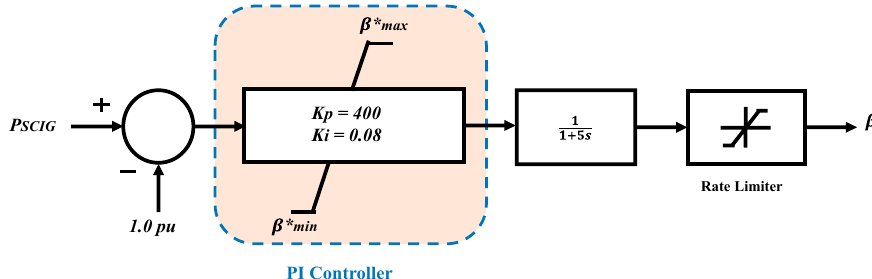
Figure 3. Pitch control scheme for fixed-speed wind turbines (FSWT).